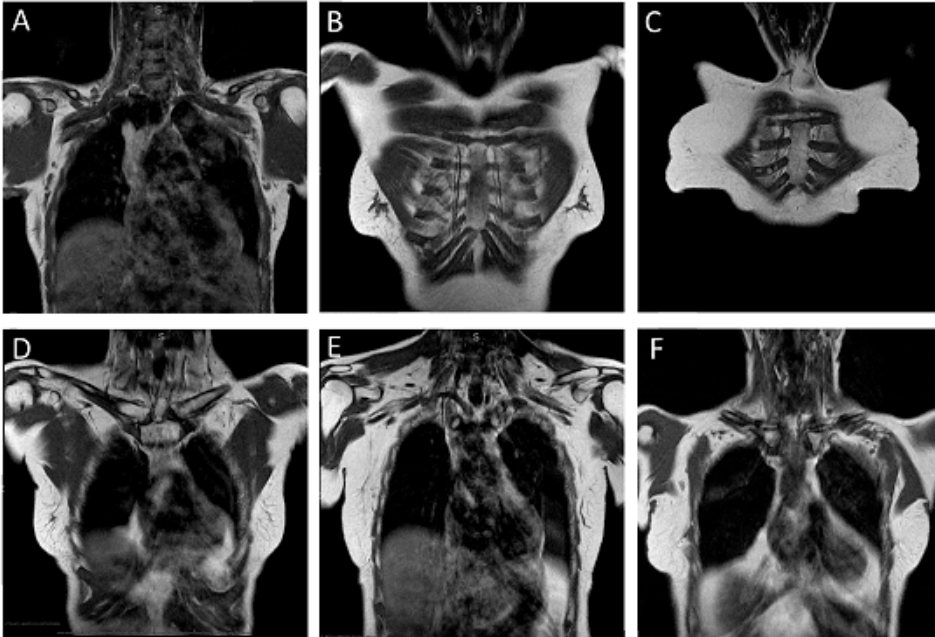
Figure 1. Normal lymph node basins. ( A ): normal axillary basins in a 70-year-old woman with newly diagnosed luminal A breast cancer of her left breast. ( B ): normal parasternal region in a 67-year-old patient with newly diagnosed Her2-positive luminal B breast cancer of the left breast. ( C ): normal parasternal lymph node in a 66-year-old woman with newly diagnosed luminal A breast cancer of her left breast. ( D , E ): normal infra- and supraclavicular basin in a 57-year-old woman with newly diagnosed luminal A breast cancer of her right breast. ( F ): normal lymph nodes in the infra-clavicular basin on the left in a 50-year-old woman with newly diagnosed Her2-negative luminal B breast cancer of her left breast.